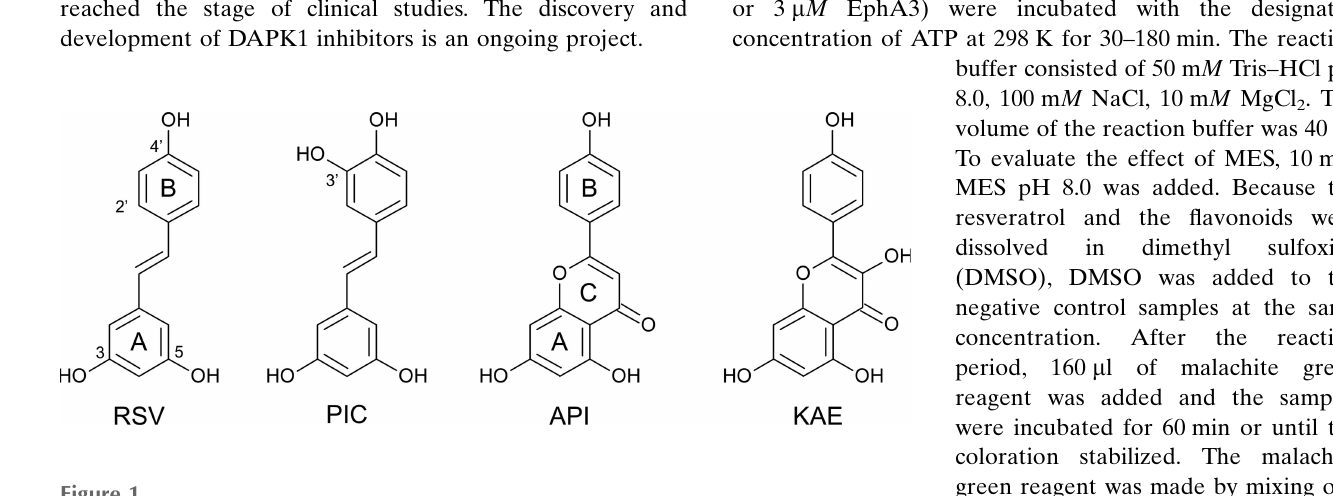
Figure 1 Chemical structures of RSV, PIC, API and